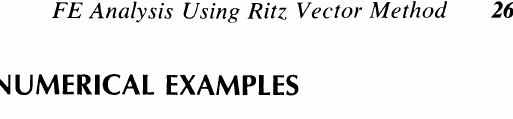
structural behavior at various times.